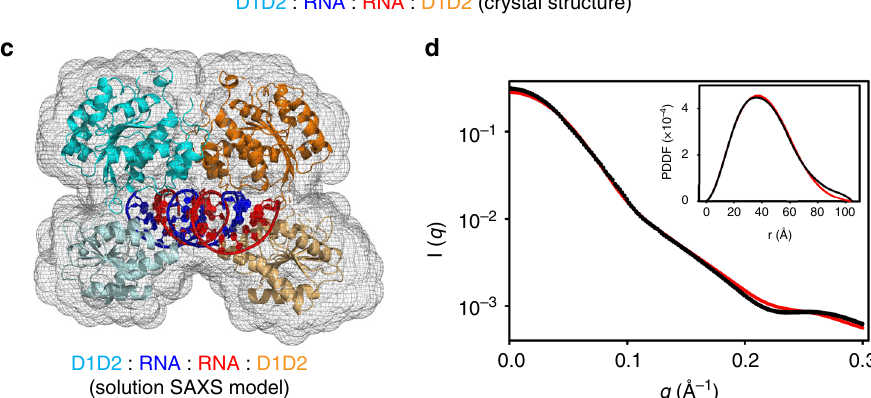
Fig. 1 Overall structure of the D1D2:dsRNA:D1D2 assembly of human DDX3X. a Domain structure of human DDX3X and conserved sequence motifs of DDXs. The minimal active construct of DDX3X helicase core (the D1D2 core, residues 132 – 607) is used for structural studies. The 12 highly conserved DDX sequence motifs are color coded: red, ATP binding; blue, RNA binding; and orange, coordination between ATP and RNA binding. b Crystal structure of the D1D2:dsRNA:D1D2 assembly in two views. The complex contains two D1D2 cores (cyan/orange) and a 23-bp double-stranded RNA (dsRNA) (blue/ red). c The D1D2:dsRNA:D1D2 structure fi ts well in the SAXS ab initio envelope. d Overlay of experimental scattering pro fi les (black) with back-calculated scattering pro fi les (red) for the D1D2:dsRNA:D1D2 complex. The inset shows the overlay of the crystal structure (red) with experimental (black) pair- distance distribution functions (PDDFs). Source data are provided as a Source Data fi